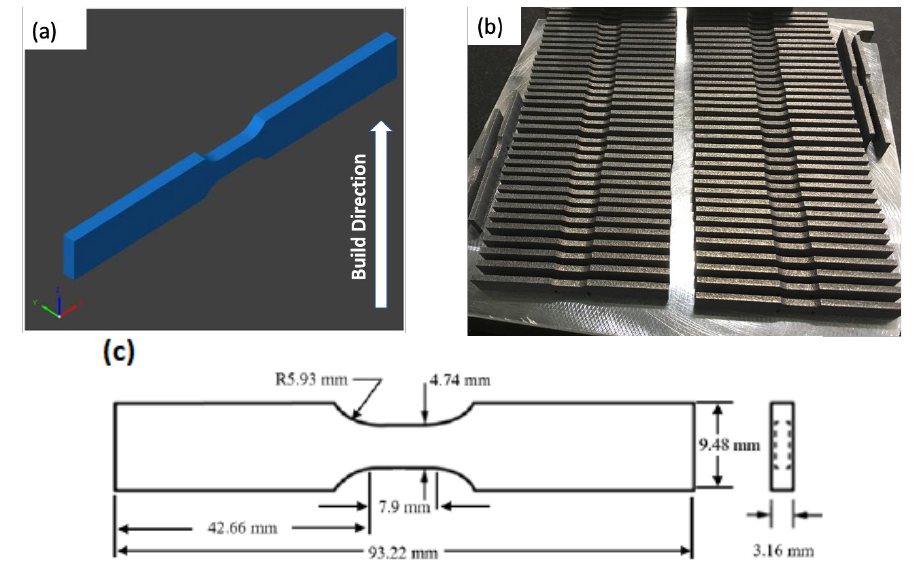
Figure 1. ( a ) Build orientation and, ( b ) as-built tensile coupons, ( c ) tensile specimen dimensions. The chemical composition of the test specimens as provided by the supplier is given in Table 1. The optimized processing parameters utilized in fabricating 58 coupons employing the island scanning strategy are as follows: laser power 400 W, laser scan speed 7.0 m/s, and powder layer thickness 30 µ m. Table 1. Chemical composition of AlSi10Mg in wt% for this study.